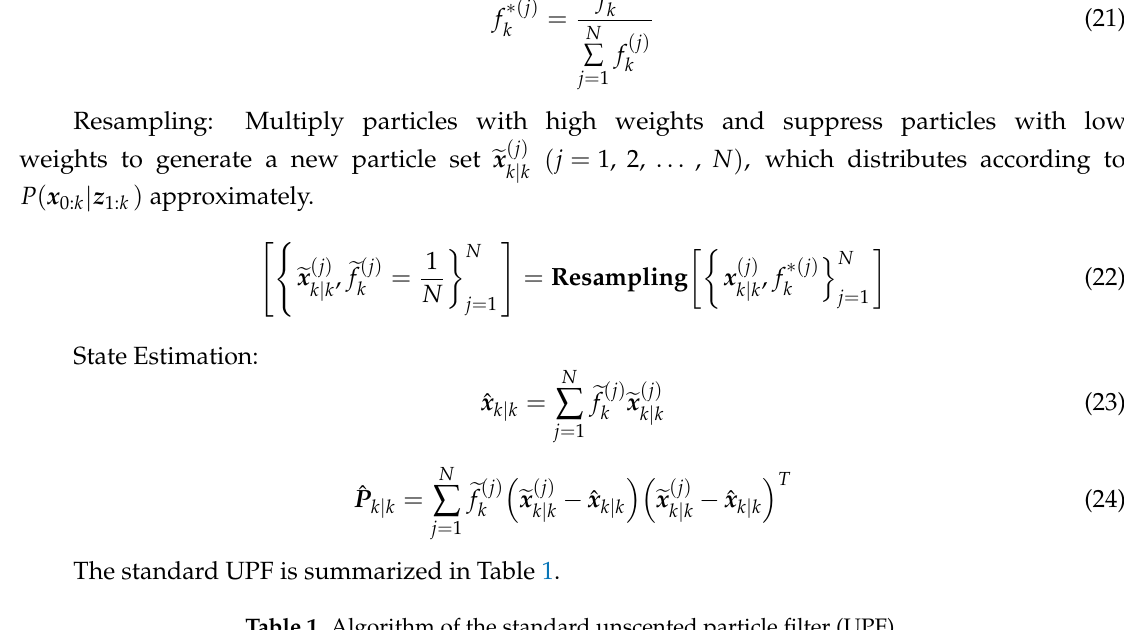
Table 1. Algorithm of the standard unscented particle filter